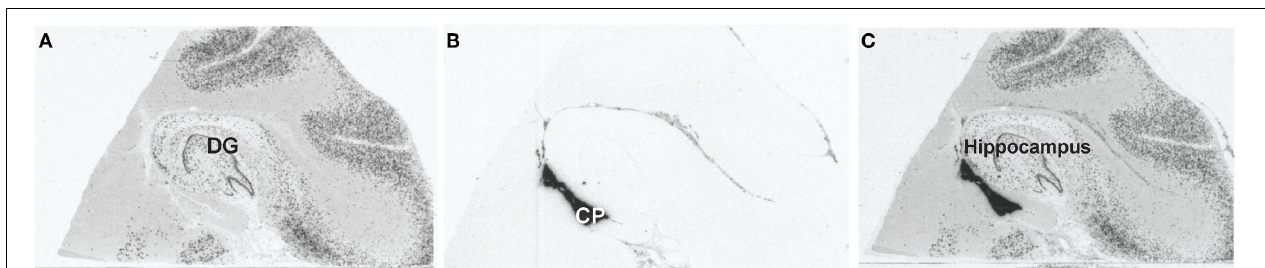
FIGURE 1 | Identifying the choroid plexus by mRNA in situ hybridization. (A) Representative image of GAD67 gene expression to identify the hippocampal level for each subject. The dentate gyrus is the C-shaped structure in this image depicting level 5 of the hippocampus.